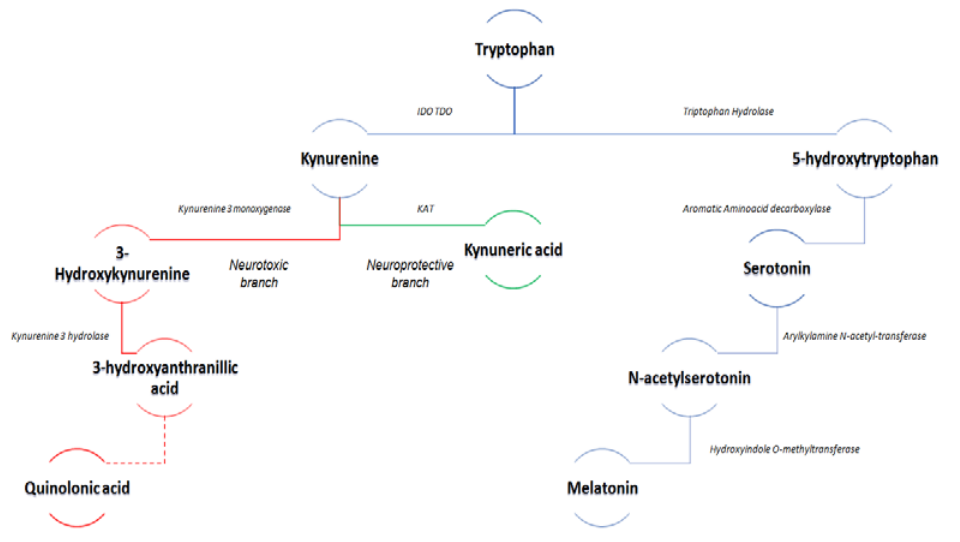
Figure 1. KYNUNERINE PATHWAY: indole-2,3-dioxygenase (IDO) and Tryptophan-2,3-dioxygenase (TDO) lead to Kynurenine synthesis from Tryptophan (TRP), which can be metabolized via two distinct pathways: the neuroprotective kynurenic acid (KYNA) branch via the KYN amino transferase enzyme (KAT), and the neurotoxic branch leading to the production of 3-hydroxy-L-KYN (3-HK) and quinolinic acid